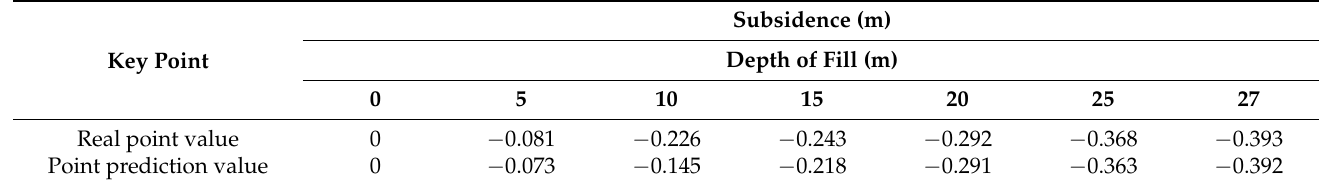
Figure 11. ( a ) FLAC3D simulation of the original ground accumulative subsidence; ( b ) subgrade center accumulative subsidence. Table 4. Subsidence of center point when filling height changes.